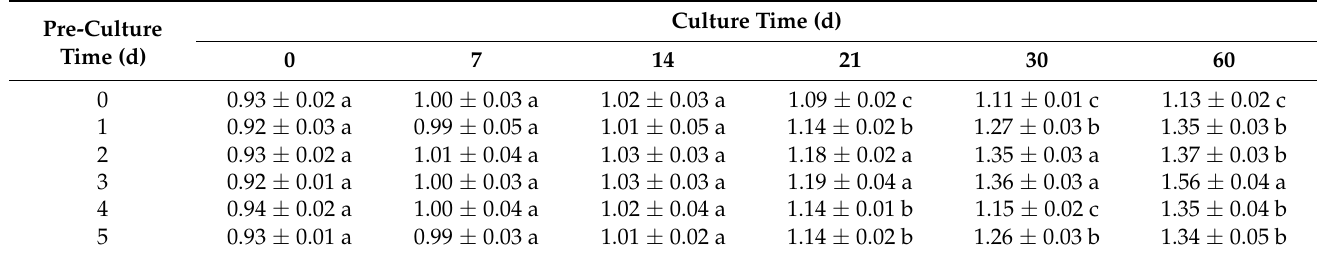
Table 2. Effect of pre-culture time on fresh weight of F. mandshurica EC after cryopreservation by